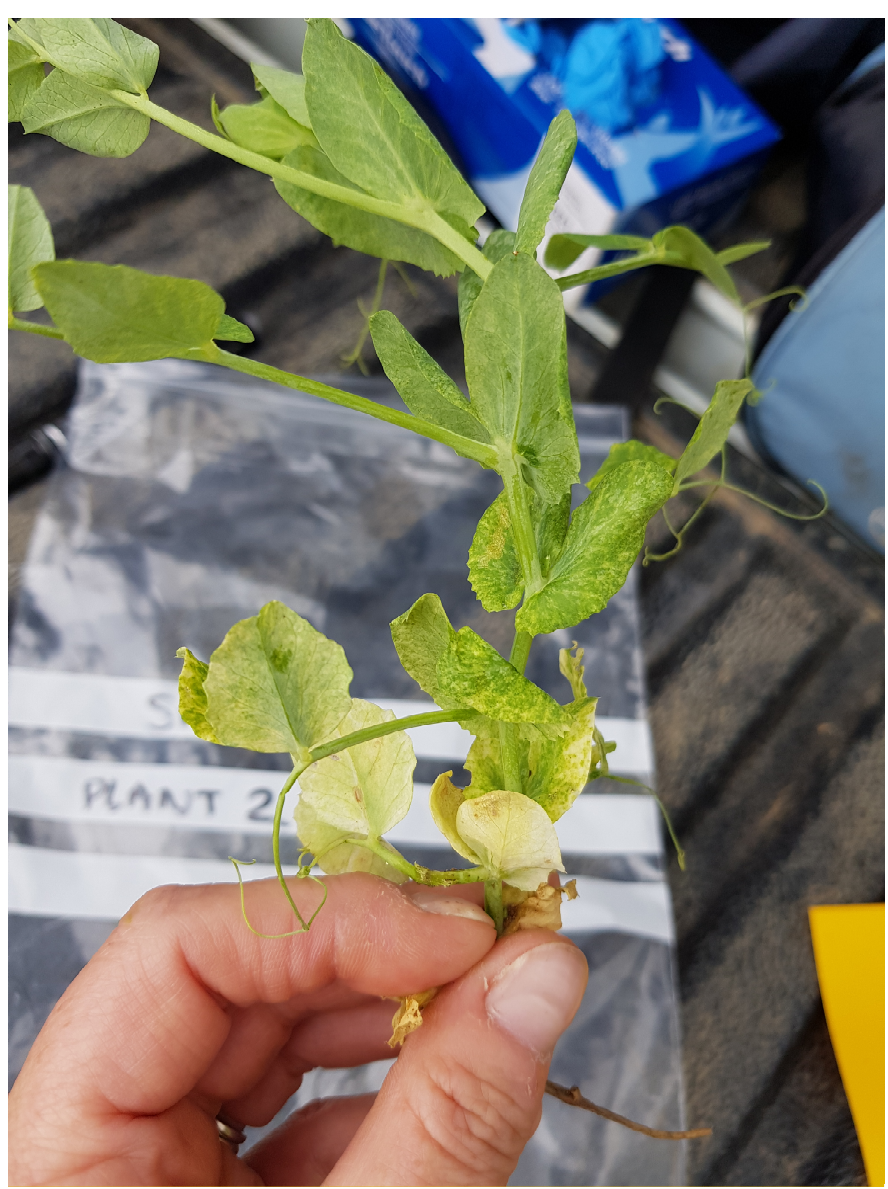
Figure 2. Symptomatic pea plant from site 19 showing mosaic symptoms.